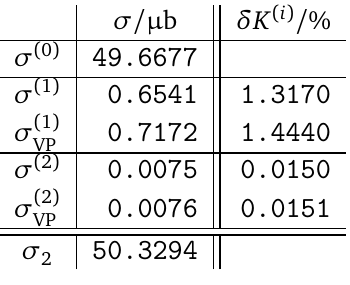
Figure 9: Differential cross section d σ/ d θ (red) with K factors. Solid (dotted) K factors are with (without) the inclusion of VP contributions.